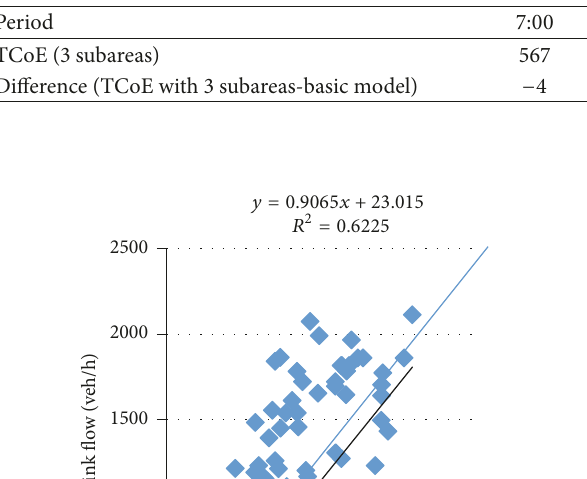
Table 2: RMS errors for TCoE with basic model and 3-subarea model.